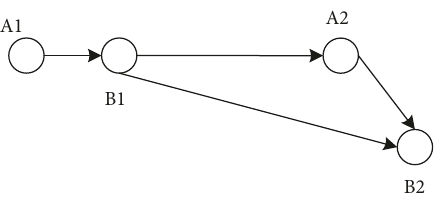
Figure 1: Travel route of the